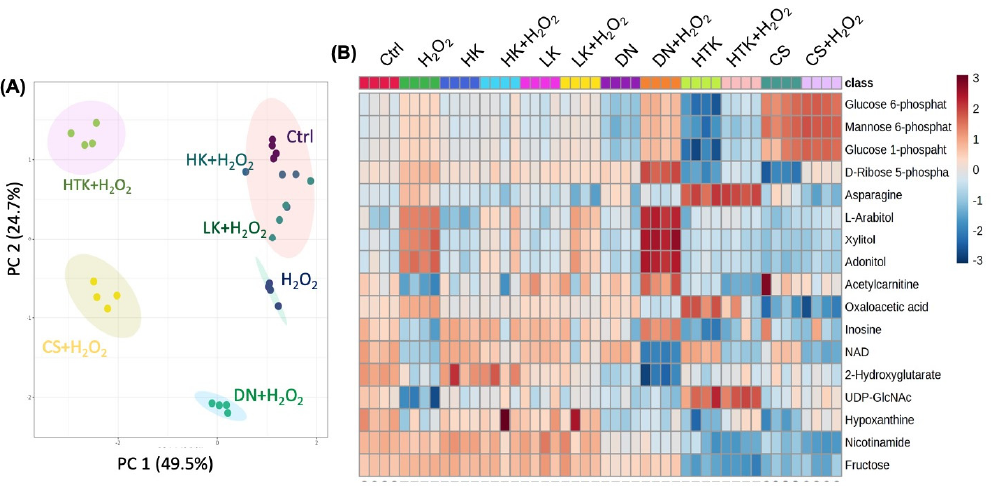
Figure 4. Effect of Cardioplegic Solutions on Metabolites Changed by H 2 O 2 Treatment. AC 16 cells at 90% confluency were serum-starved in 0.5% FBS DMEM/F12 overnight. The cells were treated with HK, LK, DN, HTK, or CS for 3 h as described in the Section 2, followed by exposure to 200 µ M of H 2 O 2 for 1 h before extraction of aqueous metabolites by 80% methanol for LC-MS/MS-